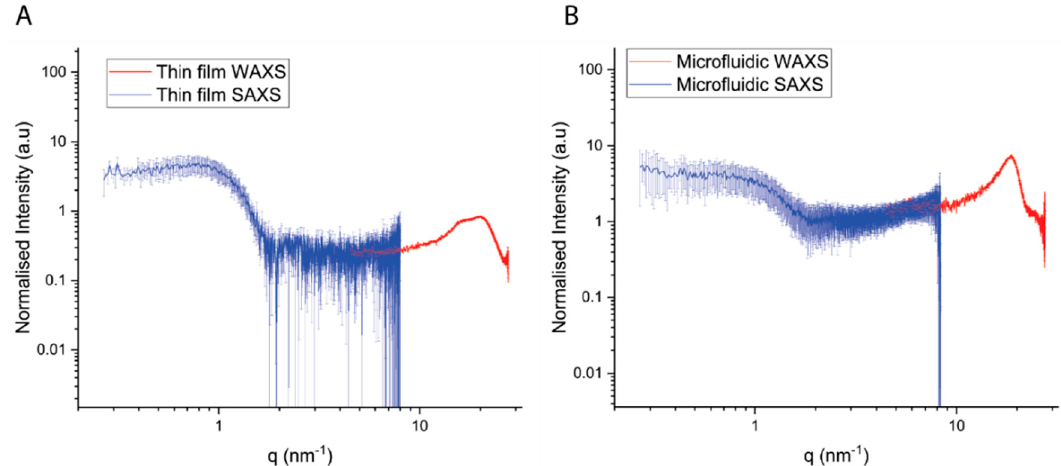
Figure 7. Normalized scattering intensity for lipid bilayer prepared via ( A ) TF, ( B ) MF. SAXS data are presented in blue, while WAXS data are in red.